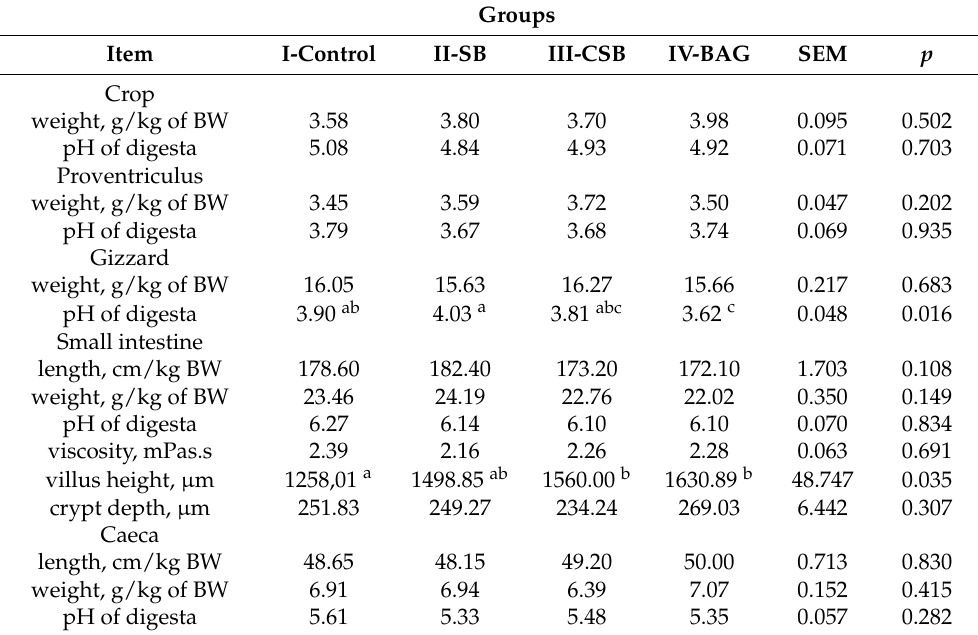
Table 4. Gastrointestinal parameters in 6-week-old turkeys.